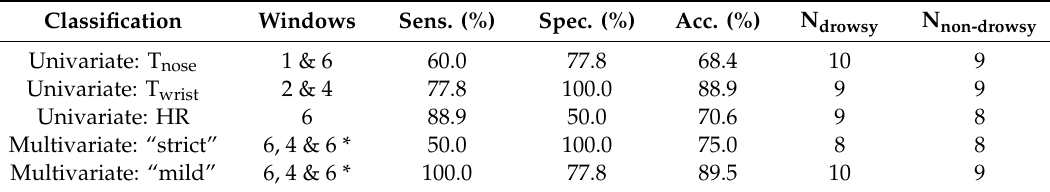
Table 2. Performance of the di ff erent classifications based on information about T nose , T wrist , and HR. The “strict” multivariate classification refers to the fact that for all three variables, the imposed constraints must hold for a driver to be classified as drowsy. The “mild” classification represents the case when a driver is labeled as drowsy when only two out of three constraints are met. The sensitivity, specificity, and accuracy are expressed as a percentage. N drowsy and N non-drowsy indicate the number of samples used in each case.